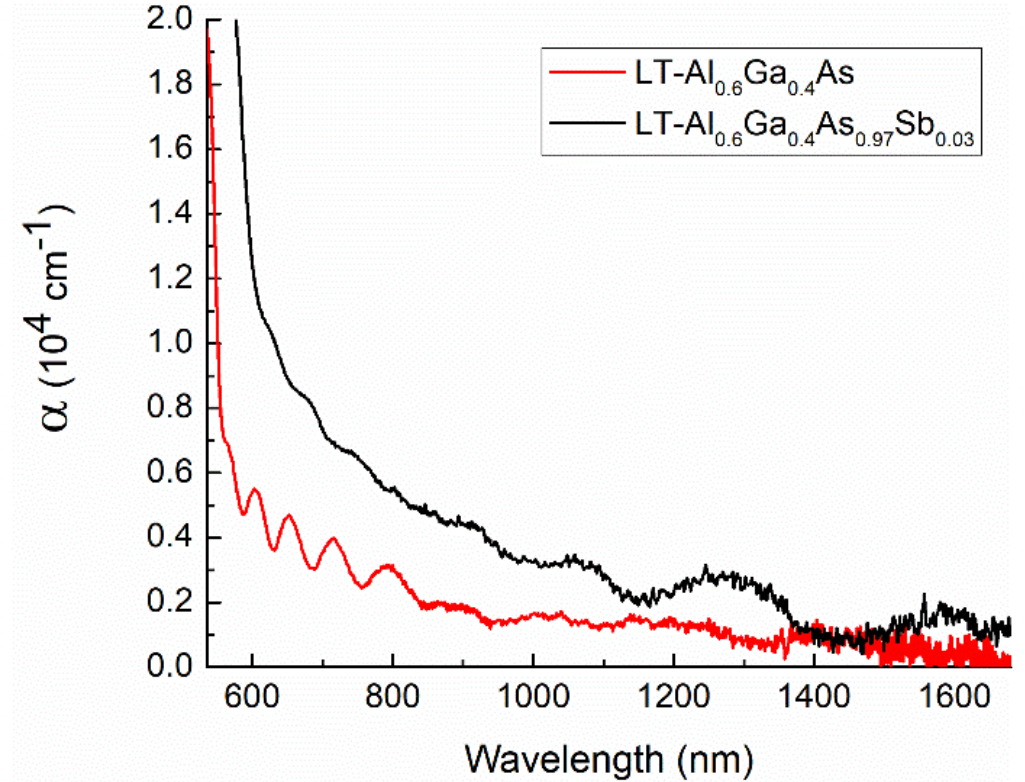
Figure 7. Optical extinction spectra of LT-Al 0.6 Ga 0.4 As (black) and LT-Al 0.6 Ga 0.4 As 0.97 Sb 0.03 (red) films annealed at 600 °C for 15 min.